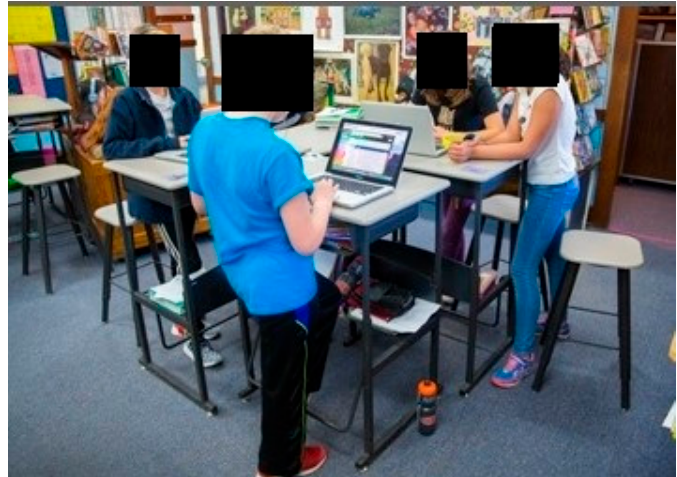
Figure 1. Students in the classroom at stand-biased desks.